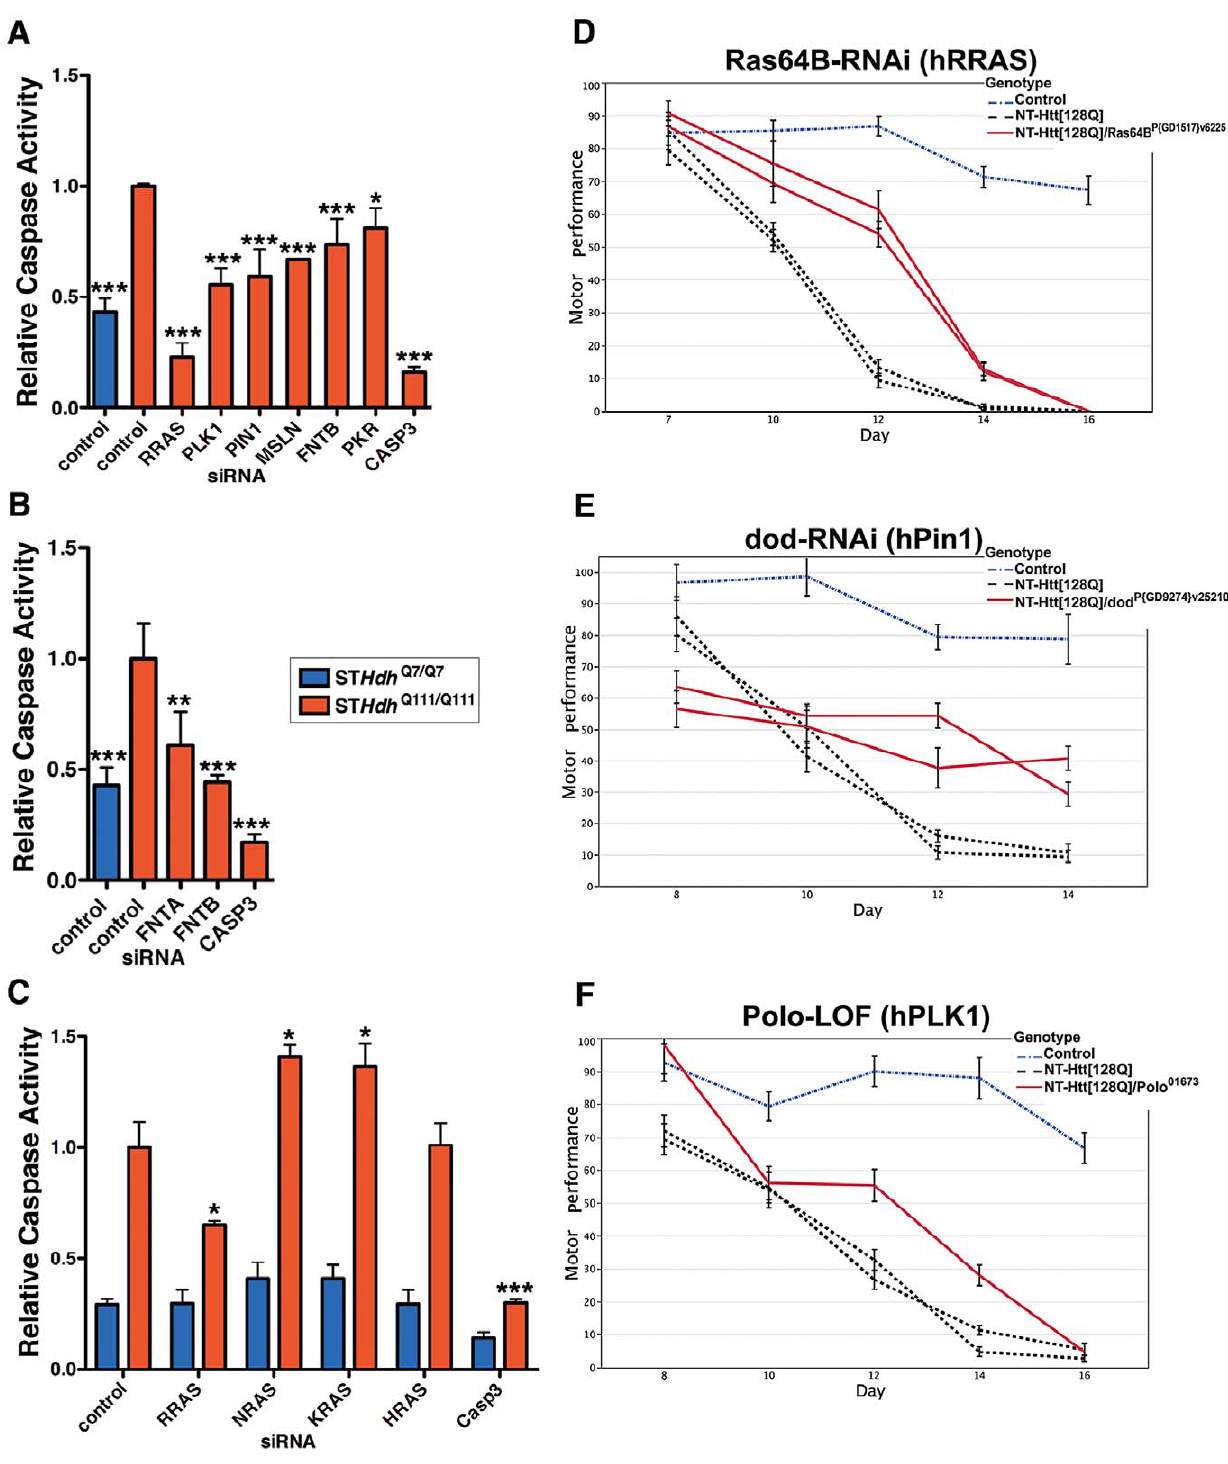
Figure 4. Suppression of Htt Toxicity by Knock-Down of RRAS Signaling Is Conserved across HD Models. (A) Knockdown of Ras signaling components in ST Hdh Q111/Q111 cells (n=3). See Figure S4A for data using individual siRNAs from deconvoluted pools. (B) siRNA targeting of subunits of the farnesyltransferase enzyme in ST Hdh Q111/Q111 cells (n=3). (C) Toxicity suppression is specific to RRAS knockdown among Ras family members tested (n=3). *p , 0.05, **p , 0.01, ***p , 0.001, ANOVA with Tukey’s Multiple Comparison Test. Figure S4B shows confirmation of knockdown by western blot. (D–F) Loss-of-function in Ras signaling components Ras64B (RRAS), dod (PIN1), and polo (PLK1) suppress motor performance defects in Drosophila melanogaster caused by expression of mutant Htt (See Figure 3C; additional results are also presented in Figure S5). Error bars represent s.e.m.